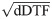
Time-frequency map of the effective coupling between CA1 and multiple cortical sites.dDTF plotted as function of time and frequency are averaged over WT (A) and APP/PS1 (B) groups. Every box shows effective coupling from the channel indicated below a given column to the channel indicated next to a given row. Time 0 indicates SWRs peak power. The color code indicates the value of the dDTF. Note strong coupling in the SWRs (130–180 Hz) and slow gamma (20–60 Hz) bands. Units: seconds (x-axis) and Hz (y-axis).